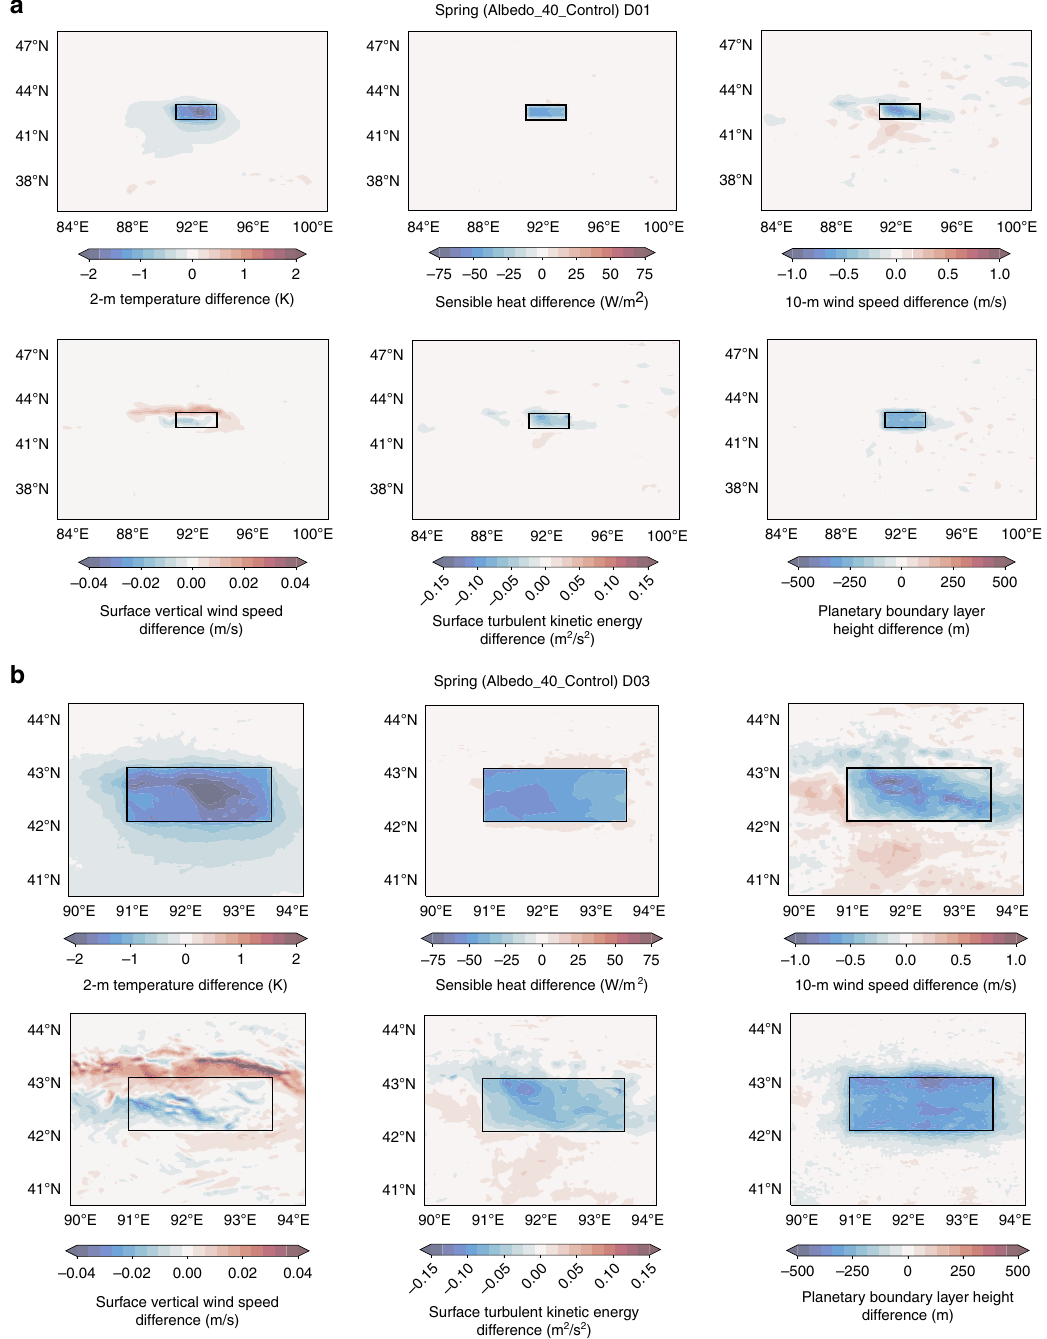
Fig. 2 Spring means of various near-surface variables for the Hami Basin. a Difference in spring (March, April, and May) means for 2-m temperature (T2), sensible heat fl ux (HFX), 10-m winds (Winds10), surface vertical wind speed (W), surface turbulent kinetic energy (TKE), and the height of the planetary boundary layer (PBLH) between the simulation where surface albedo was set to 40% (Albedo_40) and the control simulation (WRF_Control) across Domain 1. Averages were obtained from all 3-h time steps at each grid point. Blues indicate lower values in the Albedo_40 simulation compared with WRF_Control, while reds represent higher values. b Same as a , but for Domain